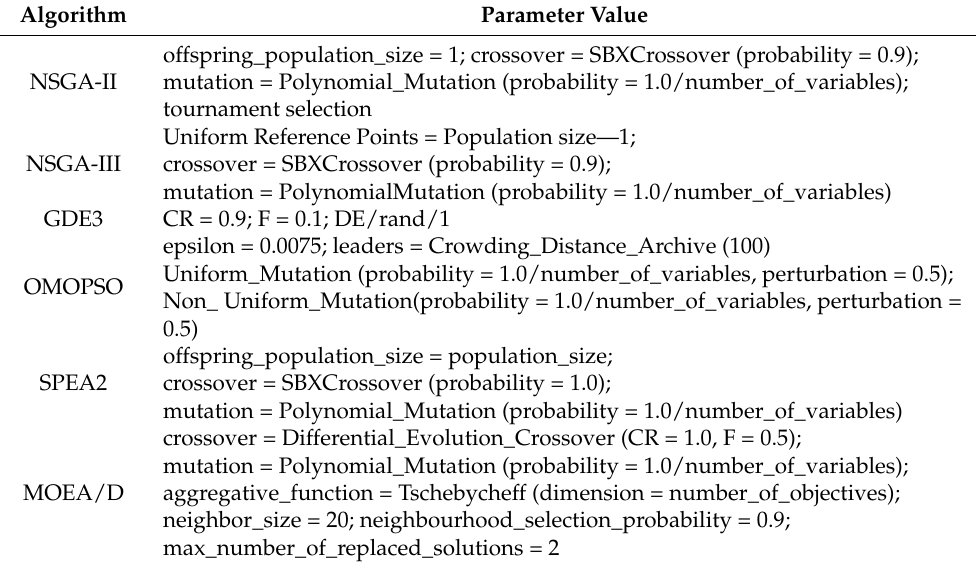
Table 1. Optimization algorithm